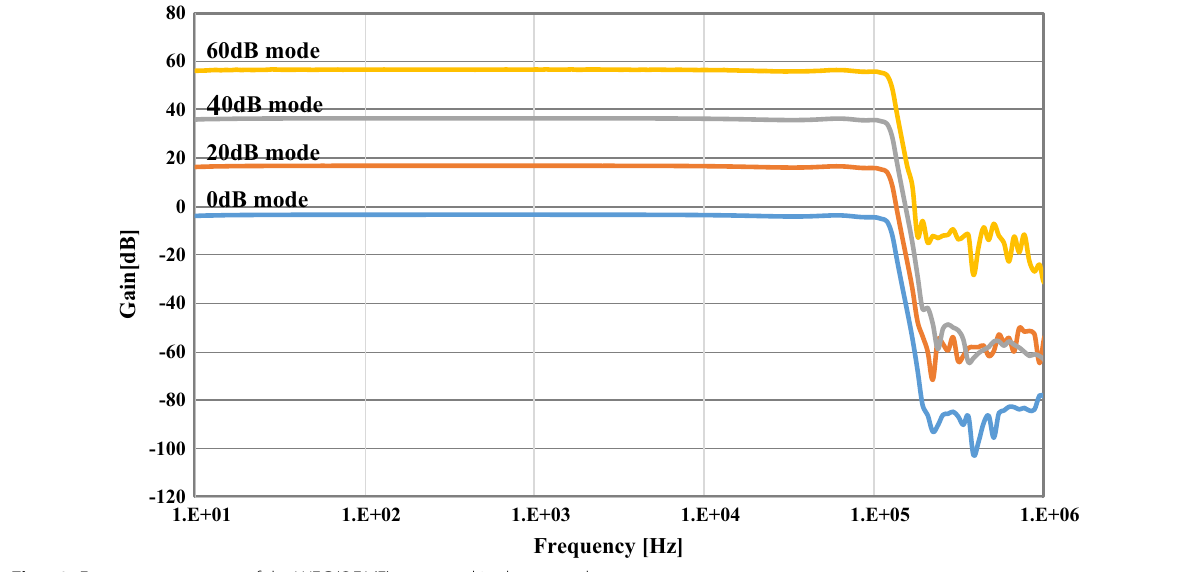
Fig. 12 Frequency response of the WFC/OFA(E) measured in the ground